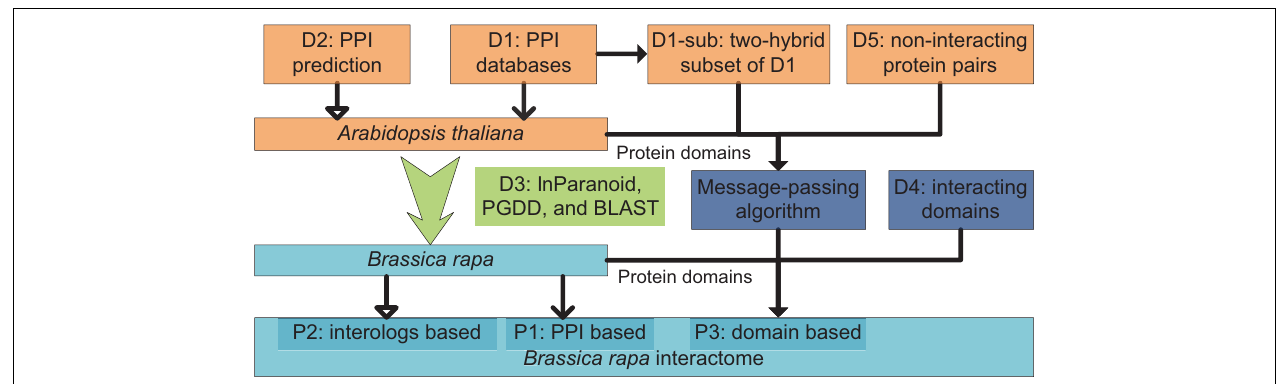
FIGURE 4 | Overview of data and methods used in the present study. Three sets of interaction predictions were obtained: P1, PPI based; P2, interologs based; and P3,